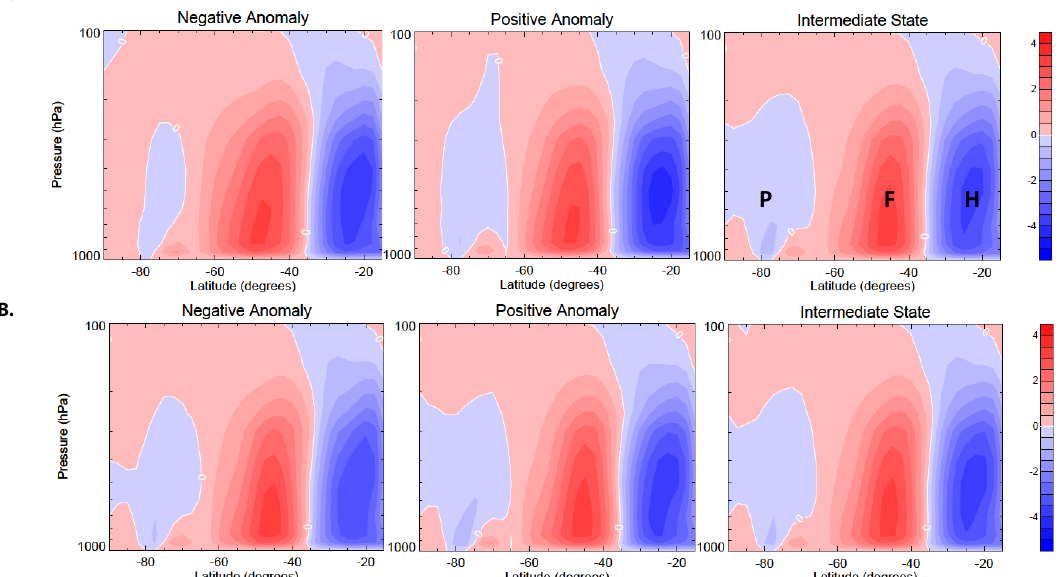
Figure 8. The deseasonalised mean meridional mass streamfunction obtained from daily mean NCEP/NCAR reanalysis (1979–2012) (Kalnay et al., 1996). Shown left to right are composites for negative, positive and intermediate monthly surface pressure anomalies in the SIO region (a) and SWP region (b) . Positive (negative) values denote clockwise (anticlockwise) rotation in the plane of the figure; the Hadley, Ferrel and polar cells are marked H, F and P, respectively. The units are 10 10 kgs − 1 . A. B.